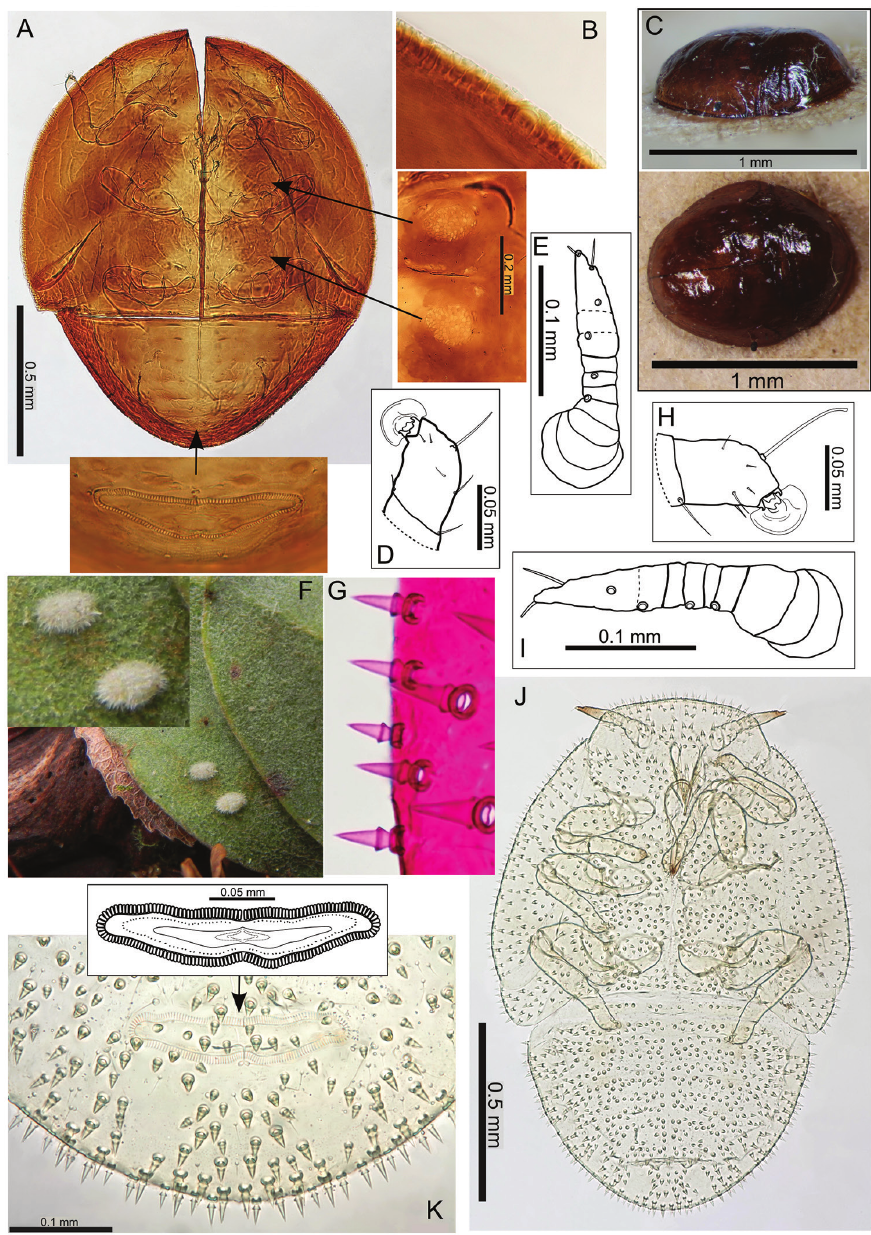
Figure 45. Pariaconus nigricapitus and Pariaconus proboscideus immatures. A–E P. nigricapitus : A 5 th instar with anal ring detail (inset below) and enlarged cells marking ventral tissue mounds (inset right) B detail of fused marginal setae C dry mounted specimen showing domed structure (lateral view above, dorsal view below) D tarsi E antenna F–K P. proboscideus : F white, hedgehog-like appearance of live specimens G detail of dorsal sectasetae (stained) H tarsi I antenna J 5 th instar K 5 th instar abdomen with anal ring detail